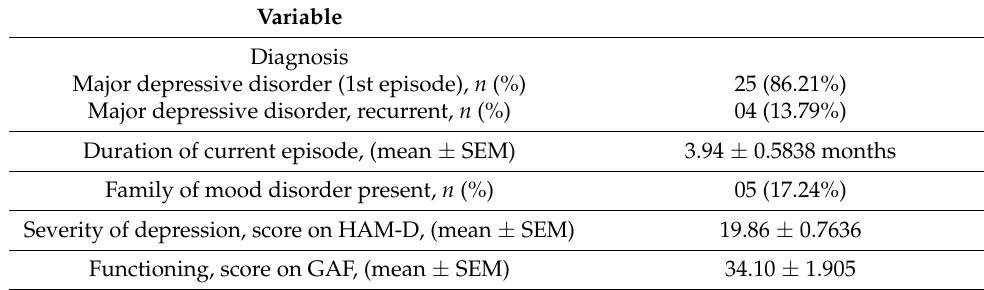
Table 2. Clinical profile of depressive patients. Variable